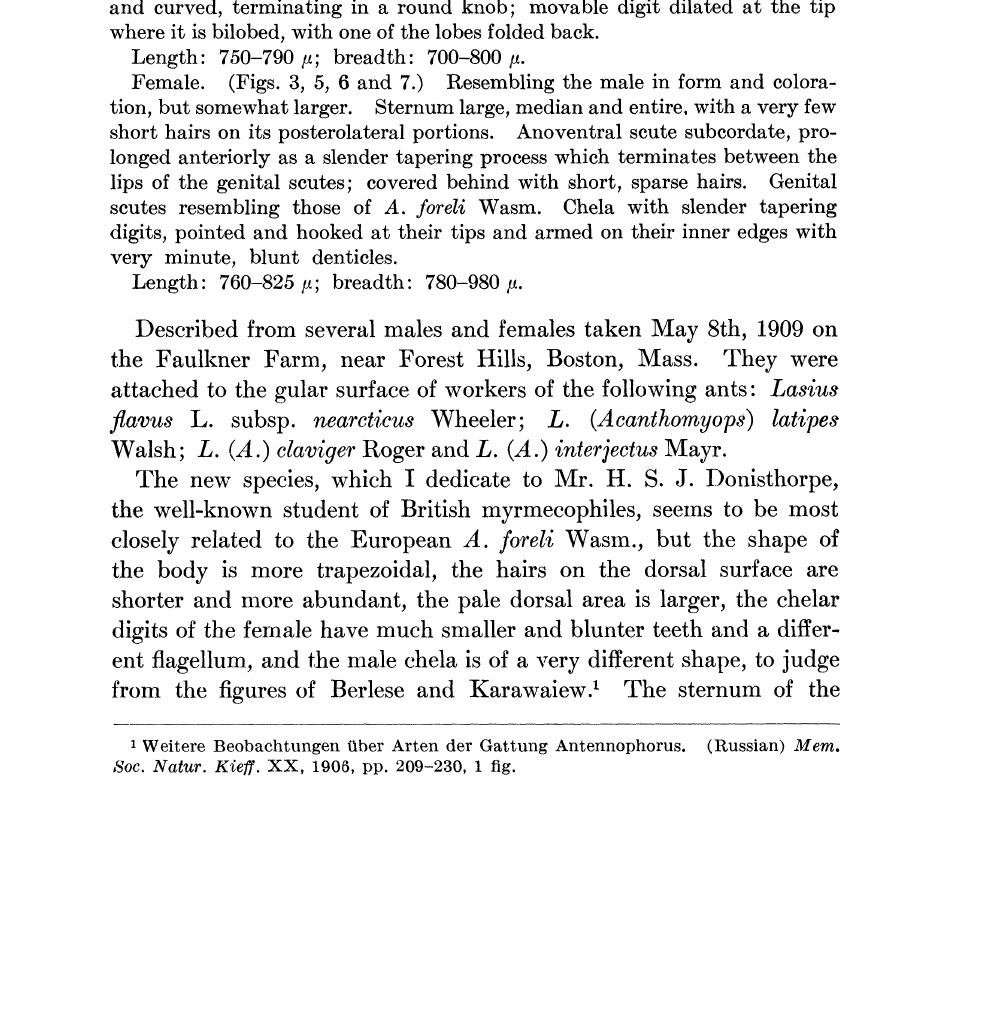
profile the dorsal scute is only moderately convex. Dorsal surface and legs yellowish brown, the former smooth and shining, not polygonally areolated under a high magnification, with a darker brown, O-shaped vitta enclosing a large, elliptical, pale central area and separated by a pale border from the edge of the dorsal scute. Ventral surface of body yellowish; sternal and ano- ventral scutes brownish. Dorsal surface densely clothed with short, rather stout hairs, which are distinctly longer and sparser in front and on the sides than behind. Legs short and stout, anterior border of coxa and trochanter of three posterior pairs not laciniate-denticulate, but entire. Hairs on the three posterior pairs of legs short, stout and distinctly curved, especially towards their tips. Sternum in some specimens connected with the lageni- form anoventral scute by a pair of slender processes, which surround the genital orifice. In other specimens (Fig. 2) the two processes are separated from the anoventral scute, and in still others they may be continuous with this sclerite but separated from the sternum. Hairs on the sternum and anoventral scute very short and sparse. Chela rather small, its fixed digit flattened, spatulate and curved, terminating in a round knob; movable digit dilated at the tip where it is bilobed, with one of the lobes folded